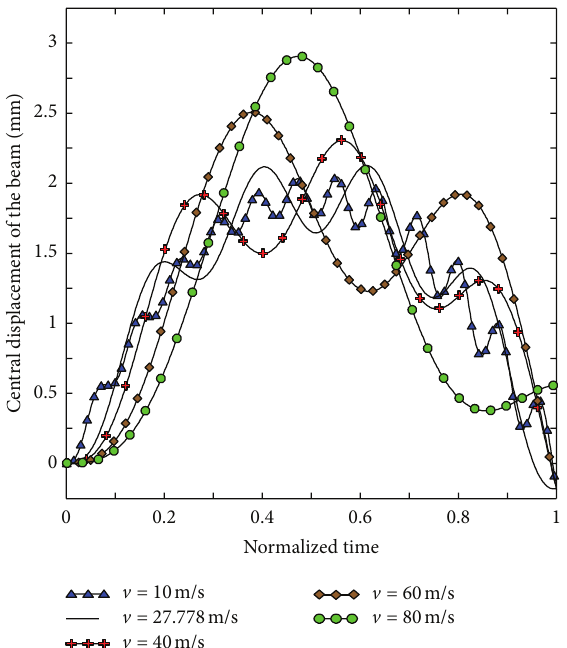
Figure 2: The dynamic response of an elastic beam at mid-span for many load